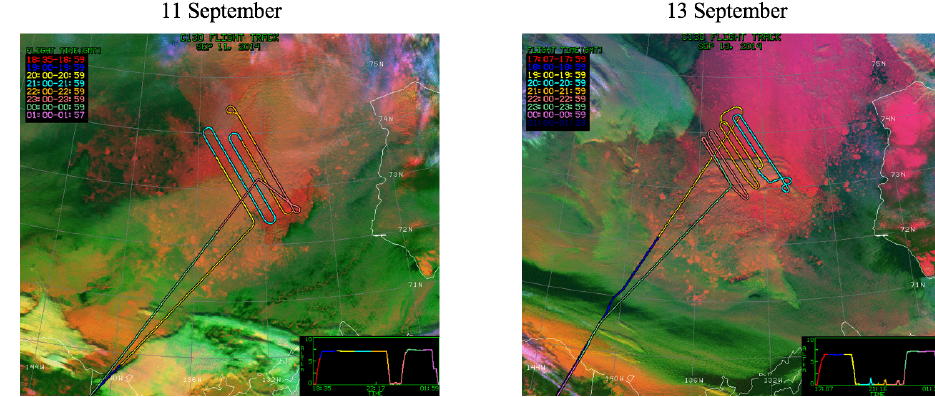
Figure 1. ARISE flight tracks overlaid on MODIS false color imagery (0.65µm for red, 11µm for blue, and 3.7–11µm for green) from NASA Langley Research Center on 11 and 13 September 2014. The focus region of these two research flights was [72.5 ◦ N, 74.5 ◦ N, 136 ◦ W, 130 ◦ W] in the marginal ice